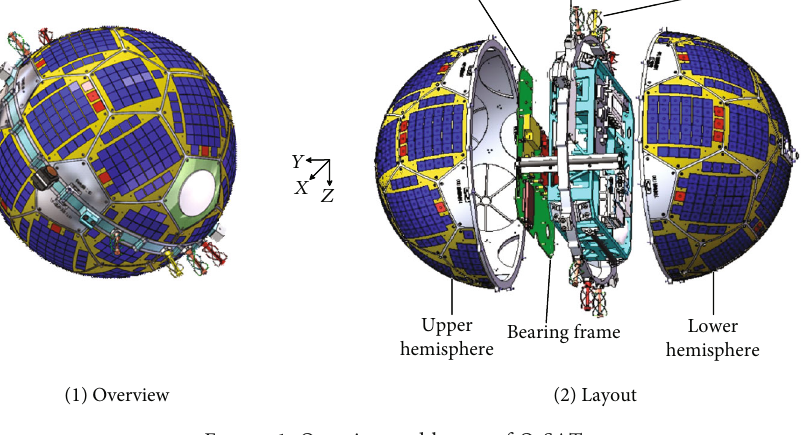
Figure 1: Overview and layout of Q-SAT.